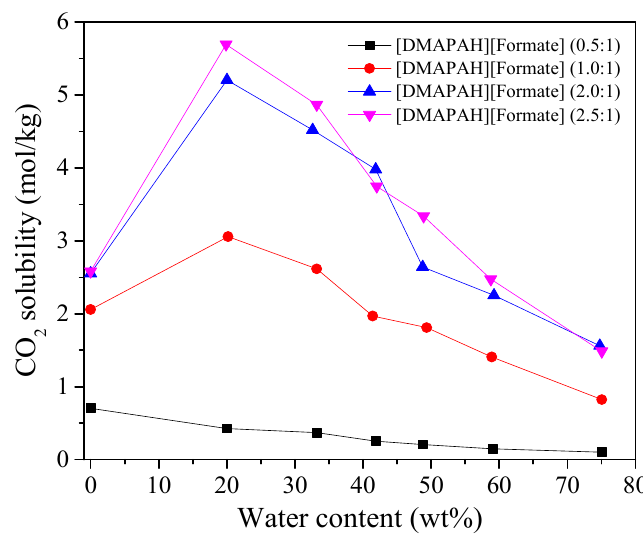
Figure 1. Effects of water on CO 2 solubility in [DMAPAH][Formate]. The values in Figure 1 are cited from Vijayaraghavan et al. [30]. Copyright 2018 Elsevier.